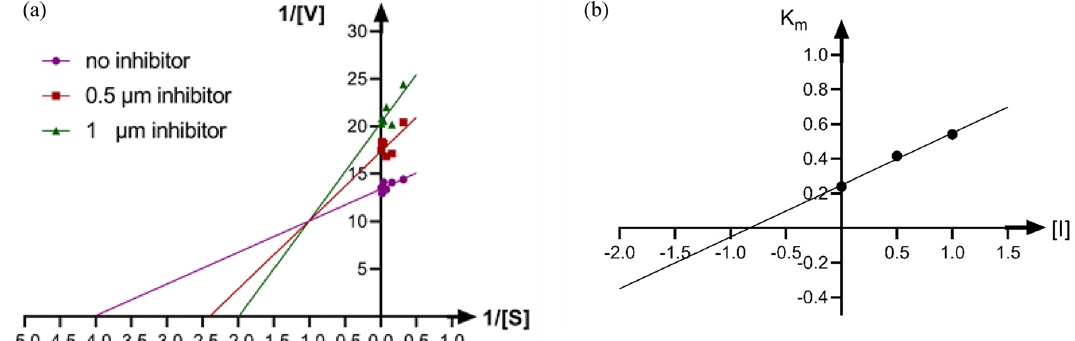
Figure 3. Kinetic analysis of urease inhibition by compound 7h . ( a ) The Lineweaver–Burk plot in the absence and presence of different concentrations of compound 7h ; ( b ) The secondary plot between 1/V max and various concentrations of compound 7h .